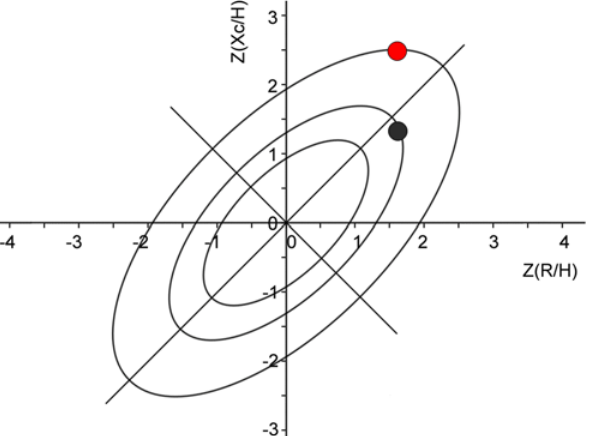
Fig 1. Mean bioelectrical values of subjects with fever (red; N = 27) and without (black; N = 25). R: resistance (Ohm); Xc: reactance (Ohm); H: height (m); Z(R/H) and Z(Xc/H): R/H and Xc/H standardized for sex and age using bioelectrical Italian standards.